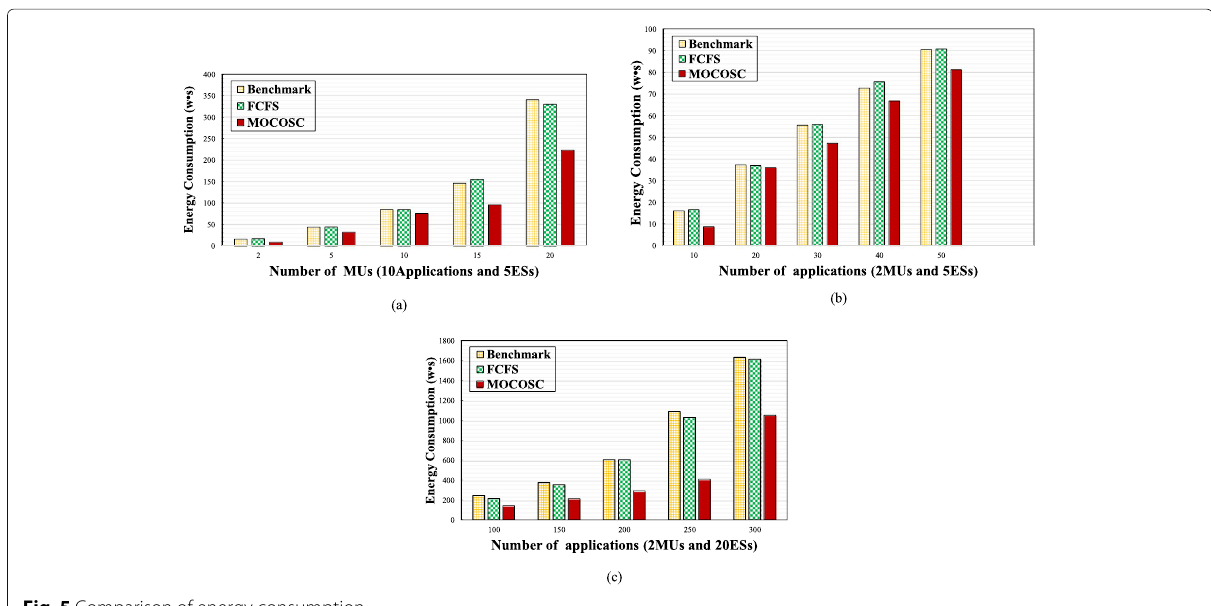
Fig. 5 Comparison of energy